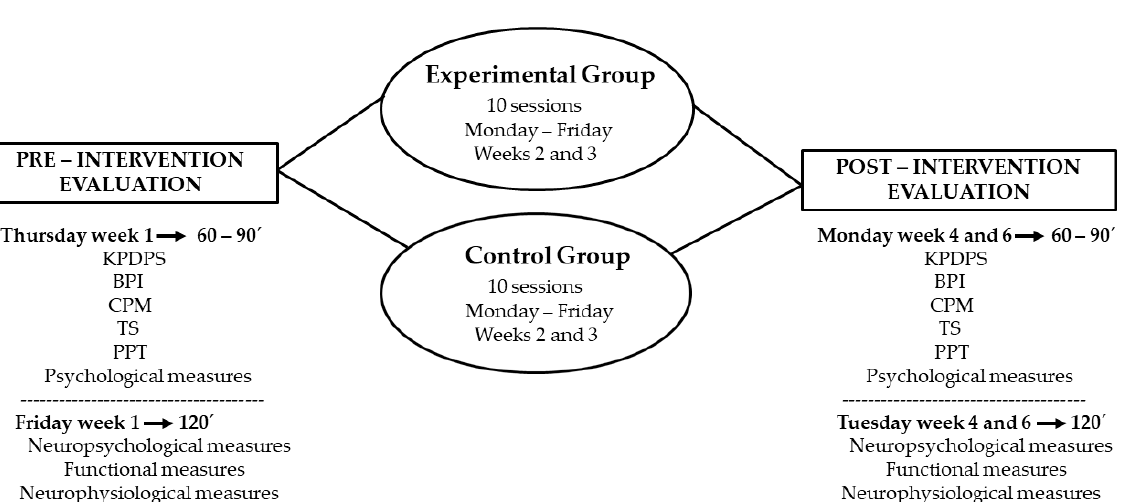
Figure 1. Schematic representation of both tDCS-based study and AO+MI-based study experimental procedures. It includes the days of the week and duration of each block of outcomes measurement in pre- and post-evaluation (KPDPS, King’s Parkinson’s Disease Pain Scale; BPI, Brief Pain Inventory; CPM, Conditioned Pain Modulation; TS, Temporal Summation; PPT, Pain Pressure Threshold; Psychological measures: Thursday/60–90 min; and Neuropsychological, Functional, Neurophysiological measures: Friday/120 min) and each treatment option (Experimental or Control group: Monday to Friday/10 sessions with the duration of each specific protocol, described in intervention protocols).